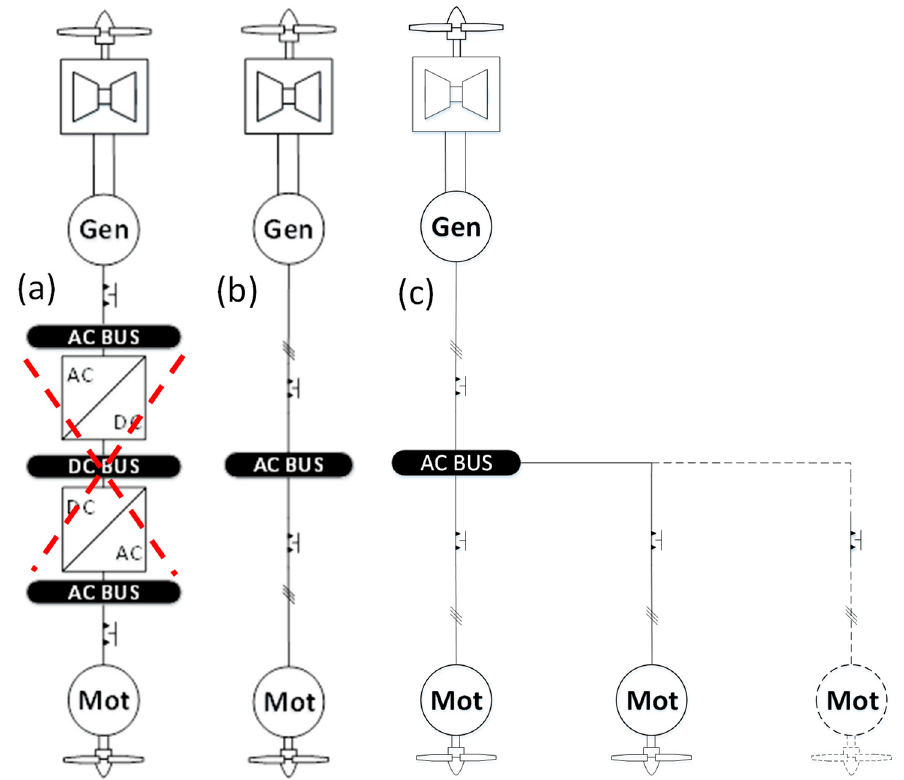
Figure 1. Several topologies for the powertrain: ( a ) with power electronics coupling; ( b ) single-motor “power electronic-less” coupling; ( c ) multi-motor “power electronic-less” coupling.